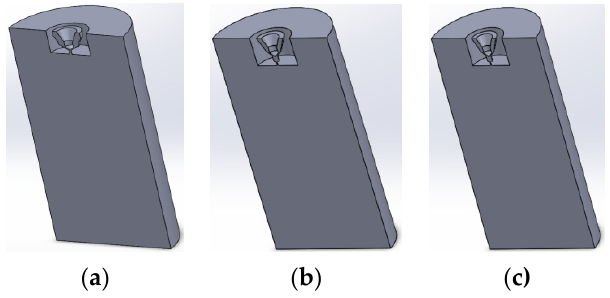
Figure 3. Computational fuel spray domains shown schematically: ( a ) single hole, ( b ) 3-holes, ( c ) 4-holes.